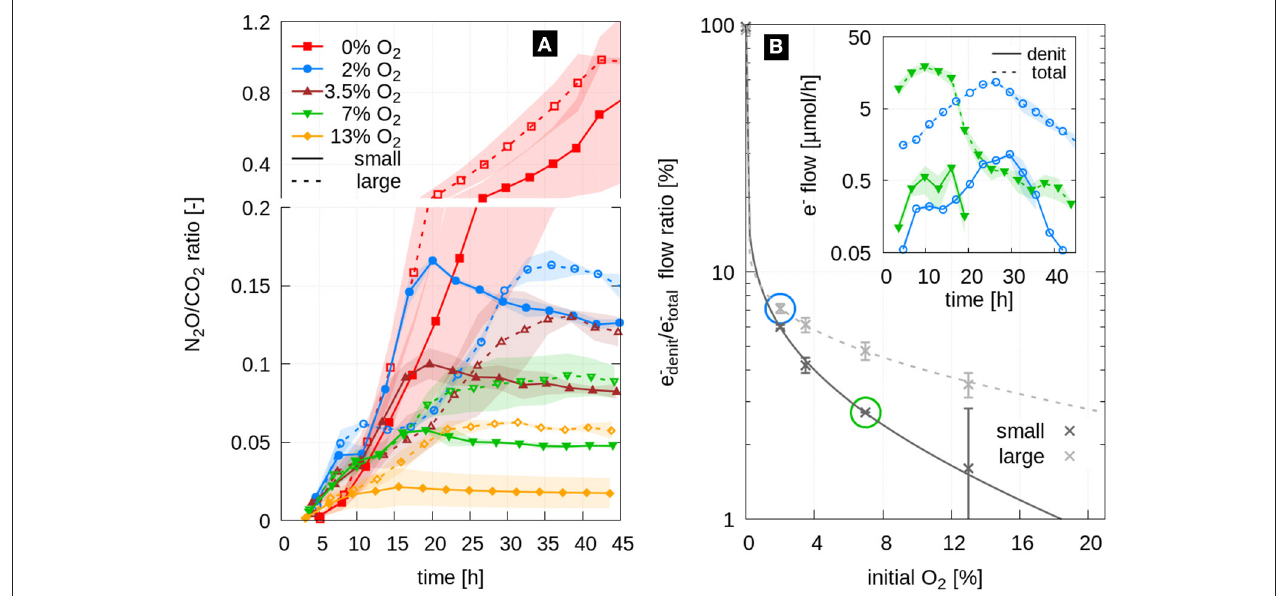
FIGURE 4 | (A) Time series of the N 2 O/CO 2 ratio shown as average (lines) and standard deviation (shaded area) for two replicates of small aggregates (solid) and large aggregates (dashed) at five different initial O 2 concentrations. (B) Ratio of electron flow diverted in denitrification and total electron flow both measured and modeled with Equation 1. The inset shows the time series of electron flows for two selected treatments (large aggregates at 2 % O 2 , blue, and small aggregates at 7 % O 2 , green). TABLE 1 | Fitting parameters ( a , b ) for the hyperbolic relationship between initial oxygen concentration and the ratio of electron flows (Equation 1) for large and small aggregates.